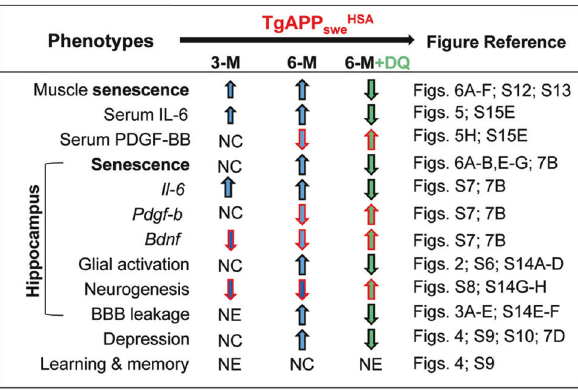
Table 1. Summary of phenotypes in TgAPP sweHSA mice